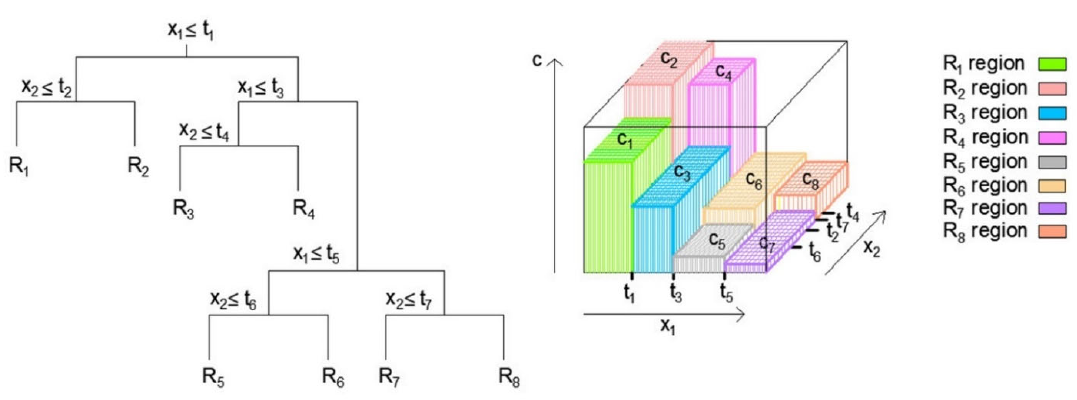
Figure 2. Schematic representation of the forecast model based on a regression tree [23].